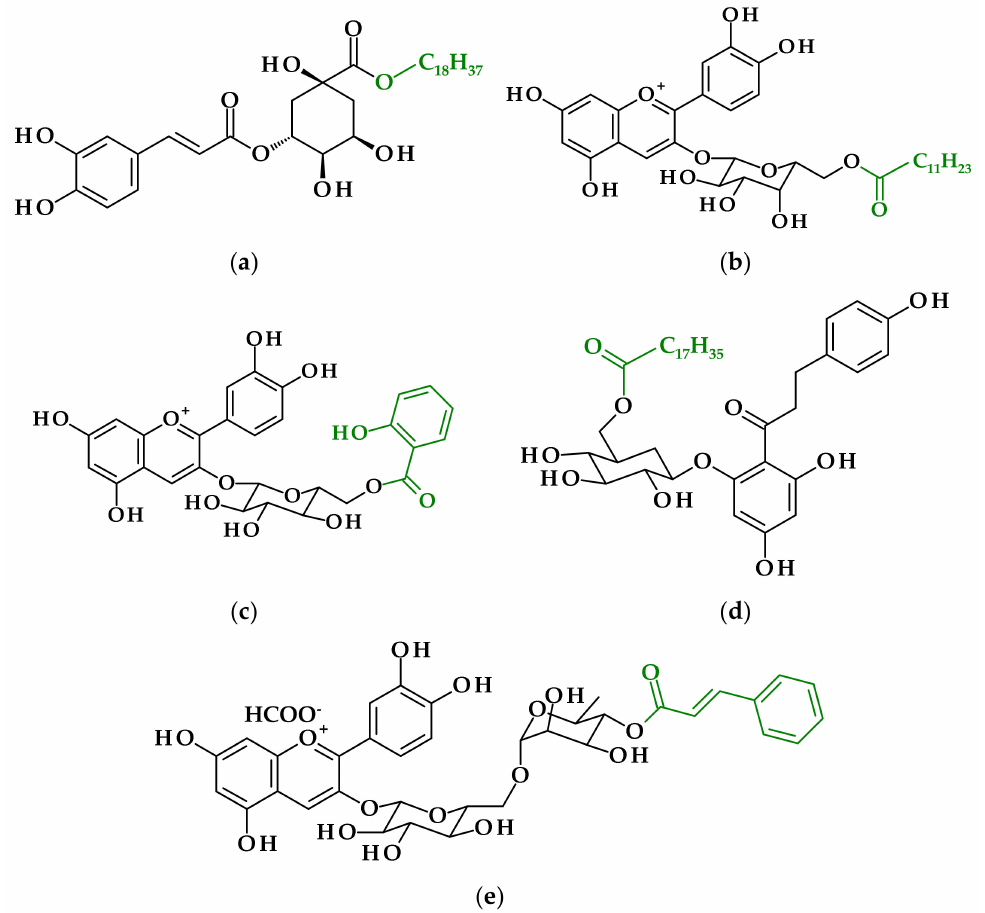
Figure 2. Phenolic derivatives from lipophilized extracts of fruits: ( a ) octadecyl chlorogenate derivative of chlorogenic acid-depside of caffeic acid and quinic acid [10]; ( b ) cyanidin-3- O -(6 (cid:48)(cid:48) -dodecanoyl)galactoside derivative of anthocyanins (glycosides of anthocyanidins) [11]; ( c ) cyanidin-3-(6-salicyloyl)glucoside–derivative of anthocyanins (glycosides of anthocyanidins) [12]; ( d ) phloridzyl octadecenoate-derivative of dihydrochalcone glucoside [13]; ( e ) cyanidin-3- O -(4 (cid:48)(cid:48)(cid:48) - cinnamoyl)rutinoside derivative of anthocyanins (glycosides of anthocyanidins)